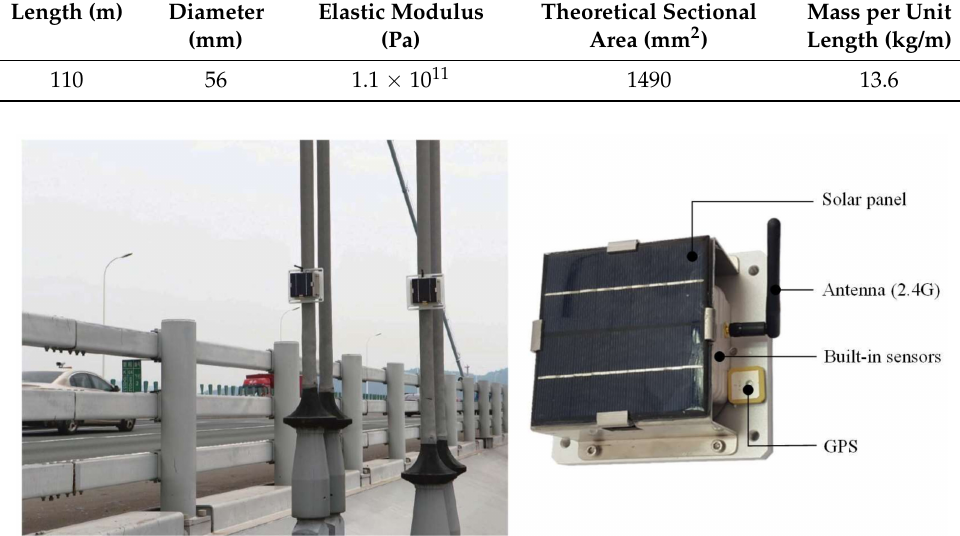
Figure 5. Wireless sensor nodes with two-axis MEMS accelerometers attached on hanger cables.